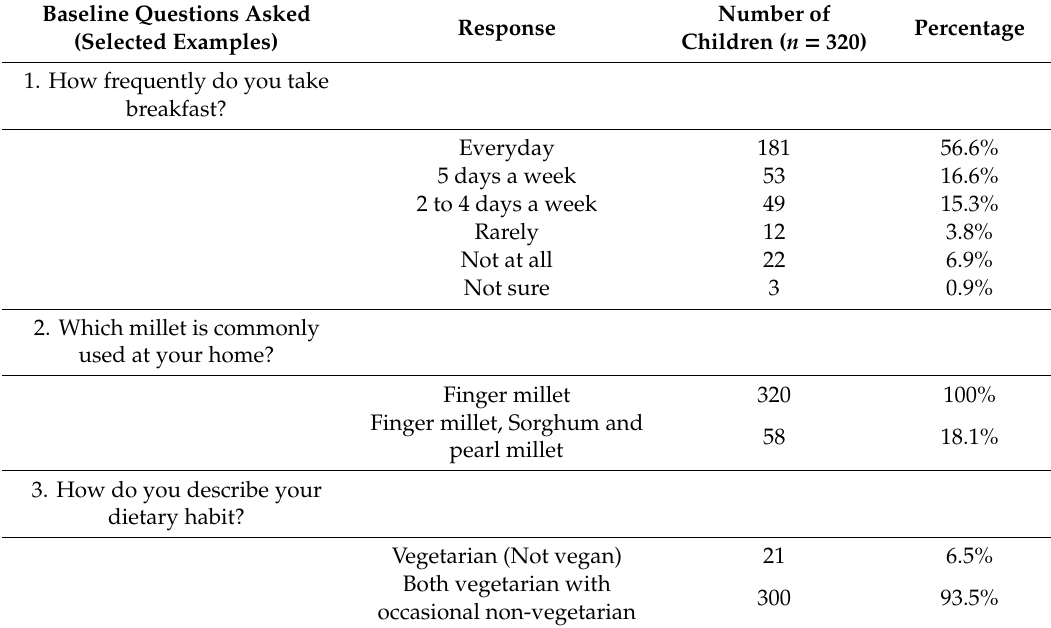
Table 3. Food habit related questions and children’s response during the baseline (a few selected example